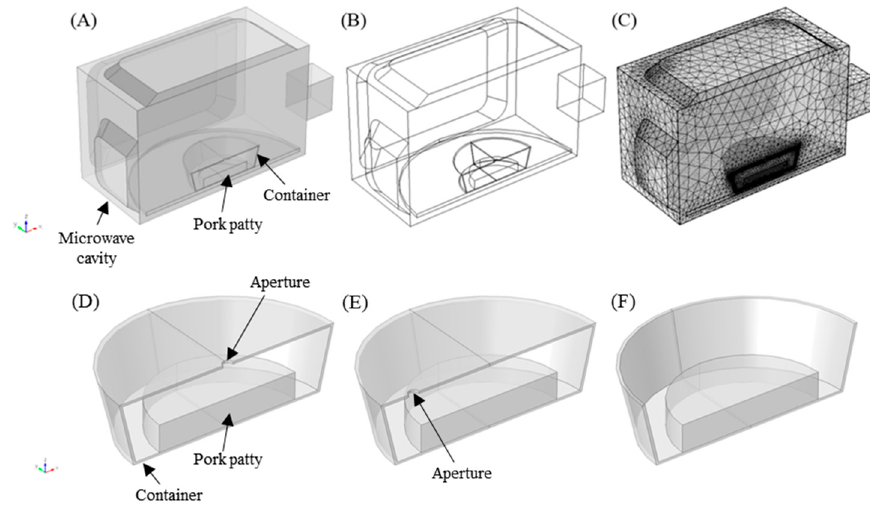
Figure 2. The 3-D geometric model developed using the COMSOL software with transparency ( A ) and wireframe rendering ( B ) image and meshing scheme ( C ) implemented for the microwave cavity, pork patty, and container, and the geometric model for the container with a center-perforated lid ( D ), edge-perforated lid ( E ), and without lid ( F ).